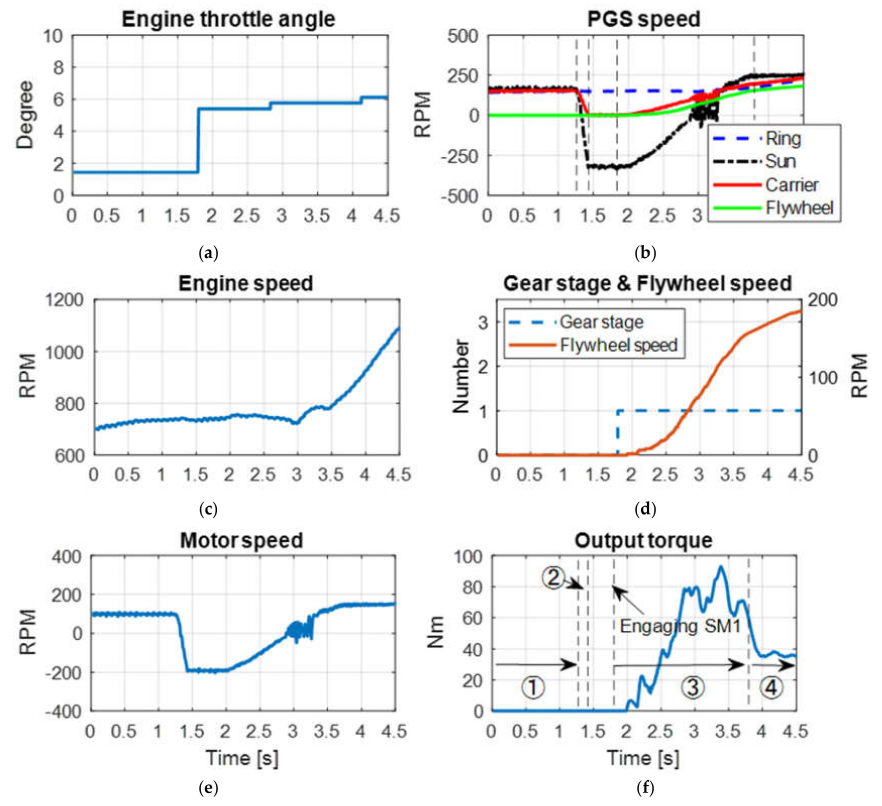
Figure 13. Experimental results of starting event: ( a ) Engine throttle angle; ( b ) PGS speed; ( c ) Engine speed; ( d ) Gear stage and flywheel speed; ( e ) Motor speed; ( f ) Output torque during shifting phases ( 1 (cid:79) Engine idling, 2 (cid:79) Carrier speed synchronization, 3 (cid:79) Starting with motor assisting, 4 (cid:79) Acceleration by the